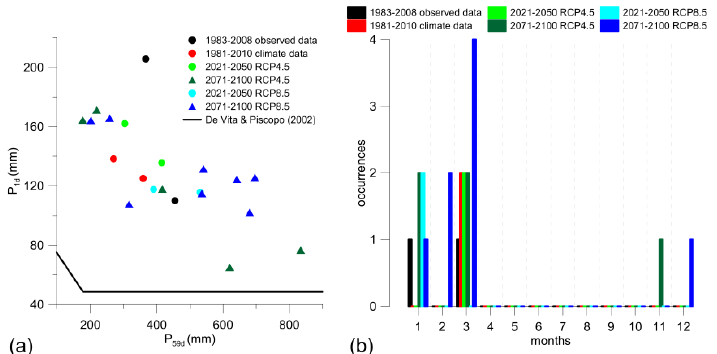
Figure 7. ( a ) observed and simulated precipitation pairs of points associated with reaching water storage threshold (see legend for indicators); P 1d represents precipitation observed on the day of occurrence, and P 59d represents cumulative precipitation on the previous 59 days; ( b ) the monthly distribution of landslide events returned by interpretative tool driven by observed or CSC data.